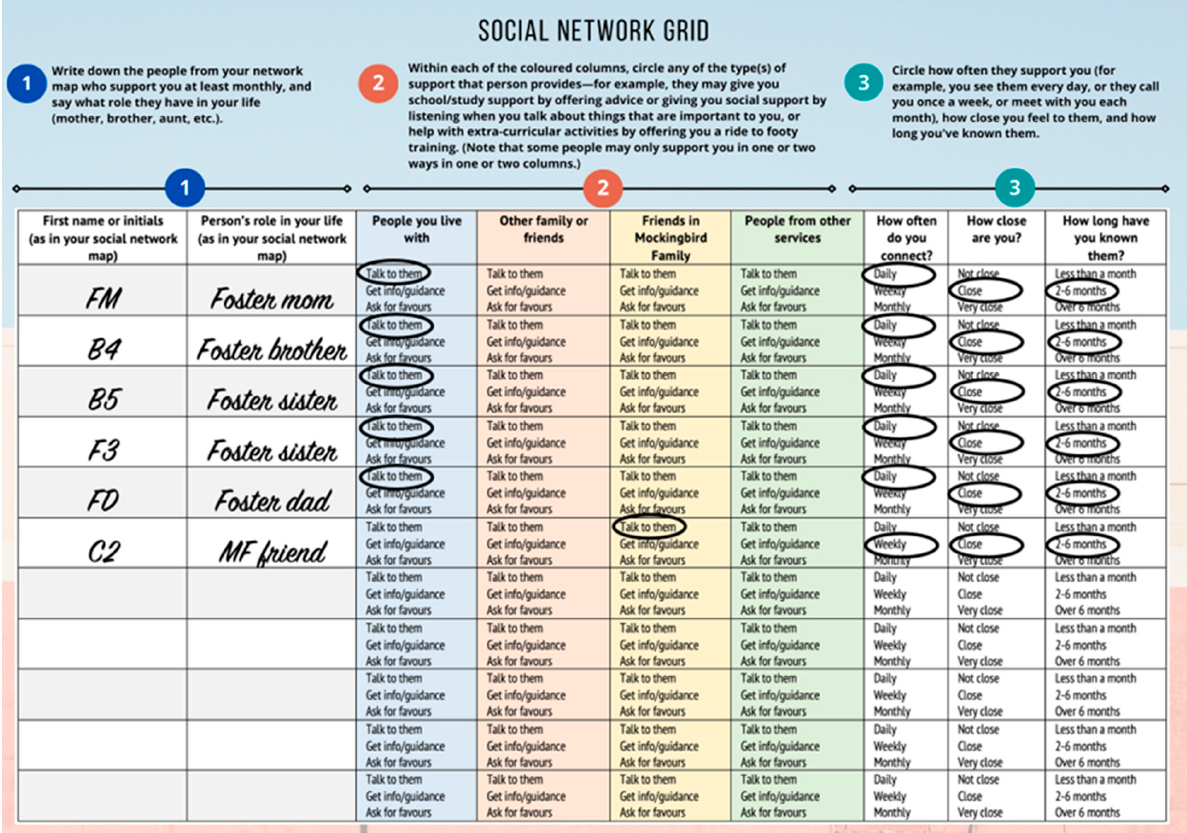
Figure 2. Example of a completed network support network grid.